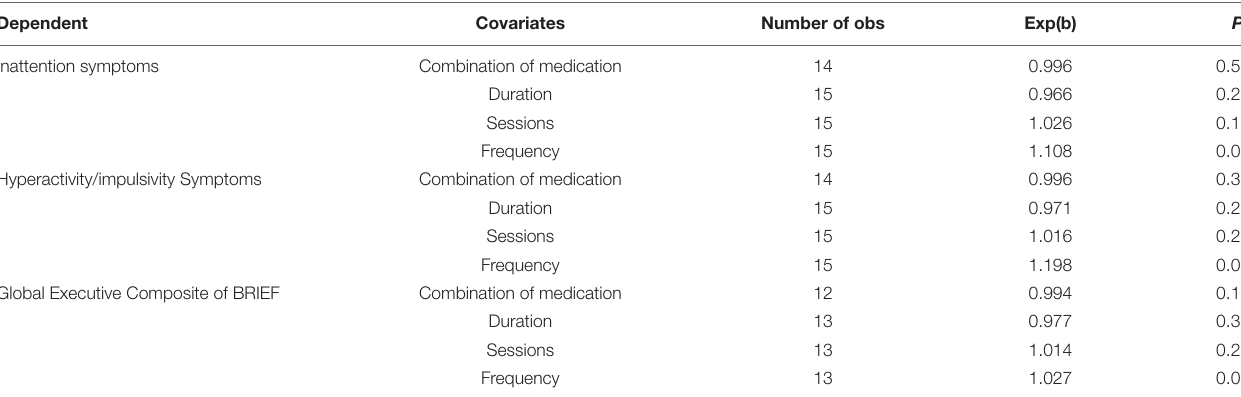
TABLE 3 | Metaregression analysis based on